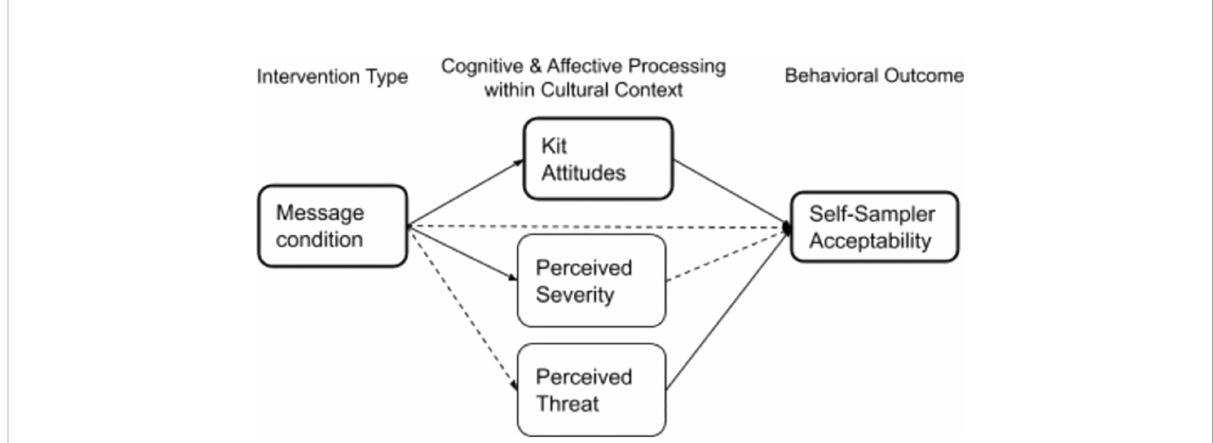
FIGURE 1 Mediations N-148. Mediation model (PROCESS Model 4) with message condition as the independent variable, and perceived threat, perceived severity and kit attitudes as mediators. Only mediators with one or more signi fi cant paths are depicted. Solid lines indicate signi fi cant paths (p<